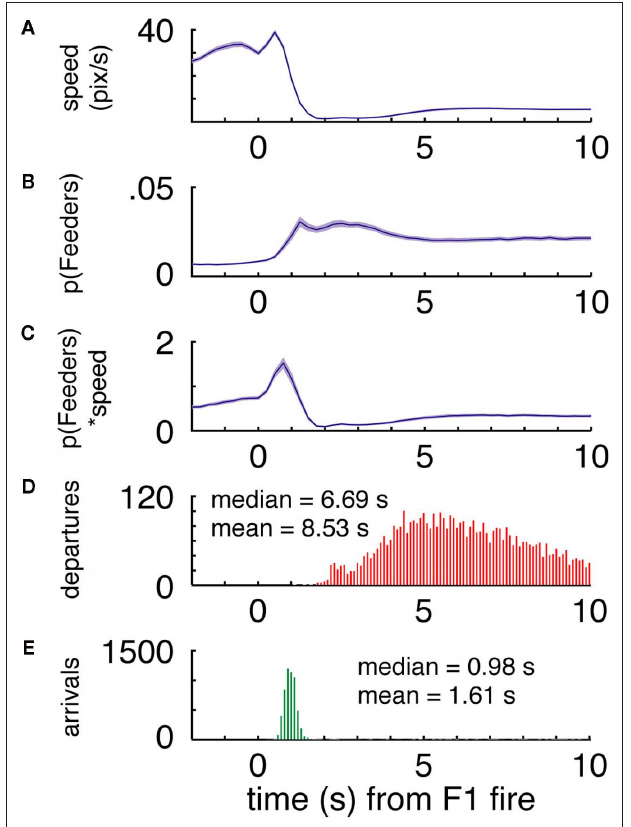
FIGURE 8 | Time at the choice point shows the specifi c time course of the increased feeder representation. (A) As in Figure 6 , passes through the fi nal choice point (CP) were divided into short (left), and long (right). As expected, as rats passed through the choice point, the red high reconstruction probability in time advanced towards time 0, when food delivery at the fi rst feeder was triggered. (Note that on average, rats arrived at the fi rst feeder 1.6 s after this time; see Figure 7 ). For long passes, there was increased probability in the 2 to 4-s range (B)